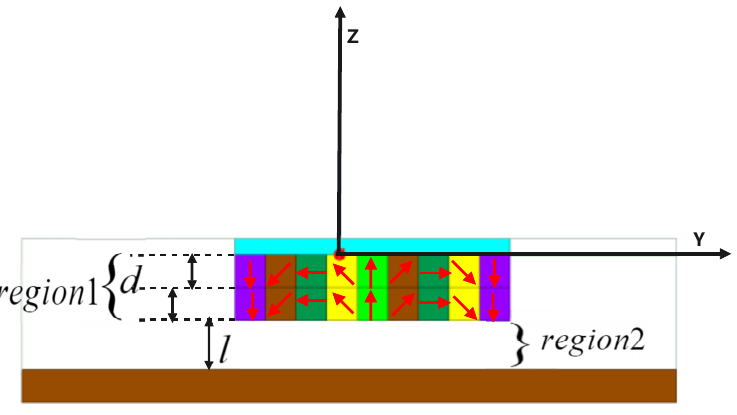
Figure 6. Schematic diagram of the double-layer Halbach array